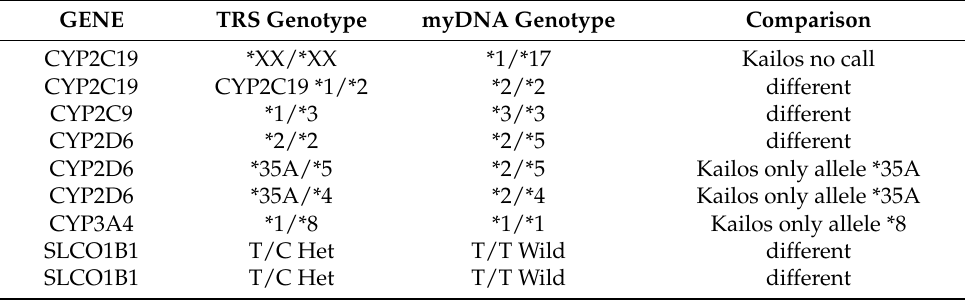
Table 2. Differences found between genes shared in the TRS and myDNA datasets. GENE TRS Genotype myDNA Genotype Comparison CYP2C19 *XX/*XX *1/*17 Kailos no call CYP2C19 CYP2C19 *1/*2 *2/*2 different CYP2C9 *1/*3 *3/*3 different CYP2D6 *2/*2 *2/*5 different